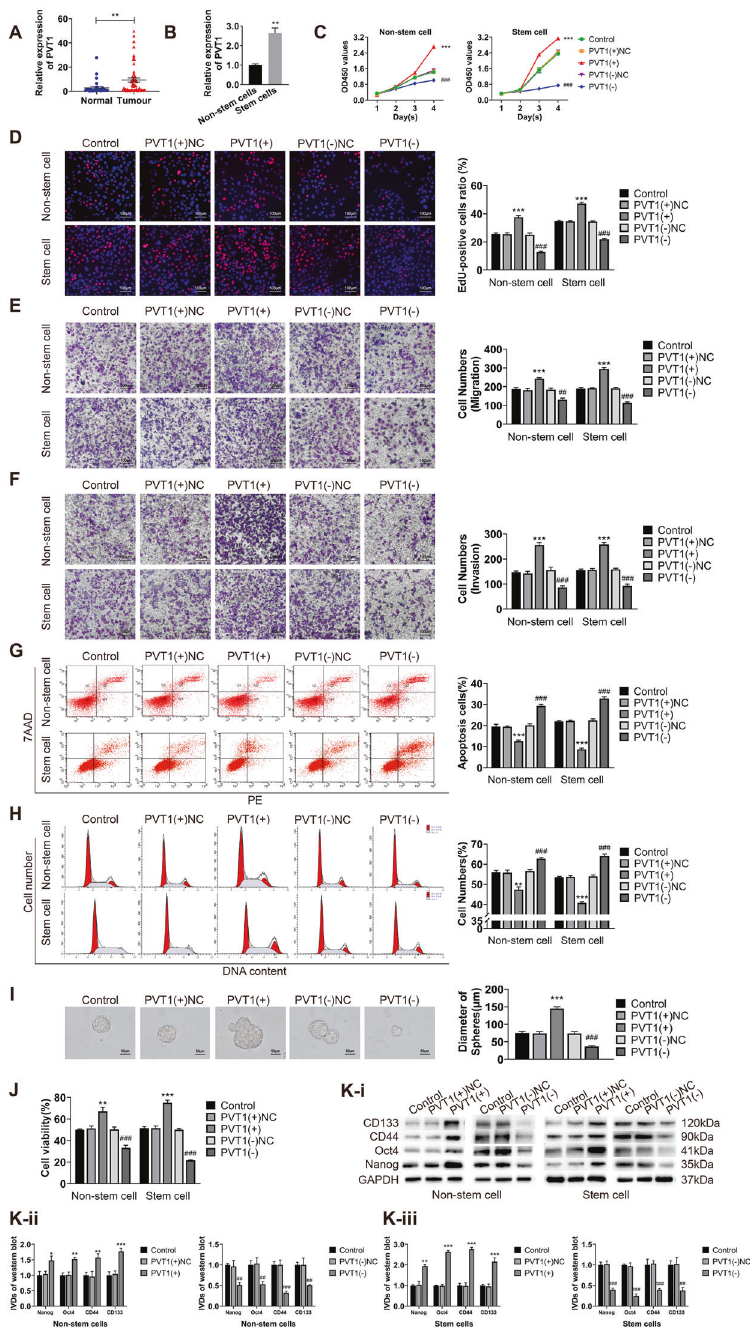
Fig. 1 PVT1 is overexpressed in endometrial cancer and promotes the malignant behavior of ECCs and ECSCs. A PVT1 expression was evaluated in endometrial cancer tissues ( n = 55) and normal endometrial tissues ( n = 30) by qRT-PCR. B PVT1 expression was evaluated in endometrial cancer non-stem cells and stem cells by qRT-PCR. C , D Effects of PVT1 on proliferation in endometrial cancer non-stem cells and stem cells evaluated by CCK8 and EdU assays. E Effects of PVT1 on cell migration in endometrial cancer non-stem cells and stem cells evaluated by transwell assays. F Effects of PVT1 on cell invasion in endometrial cancer non-stem cells and stem cells evaluated by transwell assays. G Effects of PVT1 on the cell cycle (G0/G1 phase) in endometrial cancer non-stem cells and stem cells evaluated by fl ow cytometry. H Effects of PVT1 on cell apoptosis in endometrial cancer non-stem cells and stem cells evaluated by fl ow cytometry. I Effects of PVT1 on cell self-renewal capacity in ECSCs evaluated by sphere formation assays. J Effects of PVT1 on resistance of CBP in endometrial cancer non-stem cells and stem cells evaluated by CCK8. K Effects of PVT1 on stemness markers (CD133, CD44, Oct4, and Nanog) in endometrial cancer non- stem cells and stem cells evaluated by western blot. Data are presented as the means ± SD ( n = 3, each group), * P < 0.05, ** P < 0.01, *** P < 0.0001 vs. PVT1( + )NC group; # P < 0.05, ## P < 0.01 and ### P < 0.001 vs. PVT1(-)NC group.